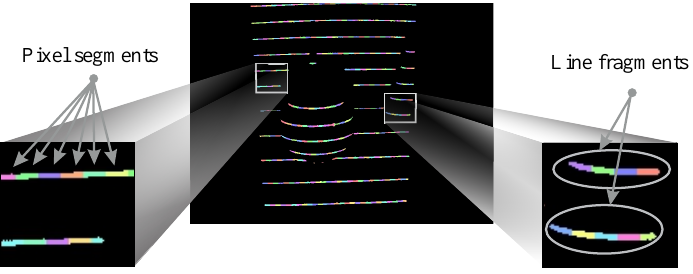
Figure 4. Visual illustration of some terminology used in this paper. Connected binary regions (using eight-adjacency) are referred to as line fragments. Smaller parts of the line fragments of fixed width are referred to as pixel